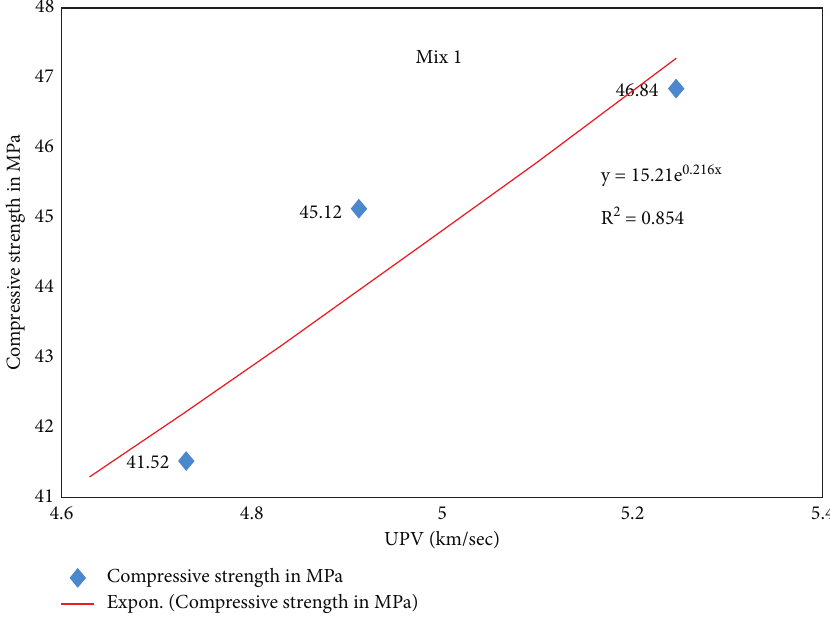
Figure 5: Relation between compressive strength and UPV for Mix 1.